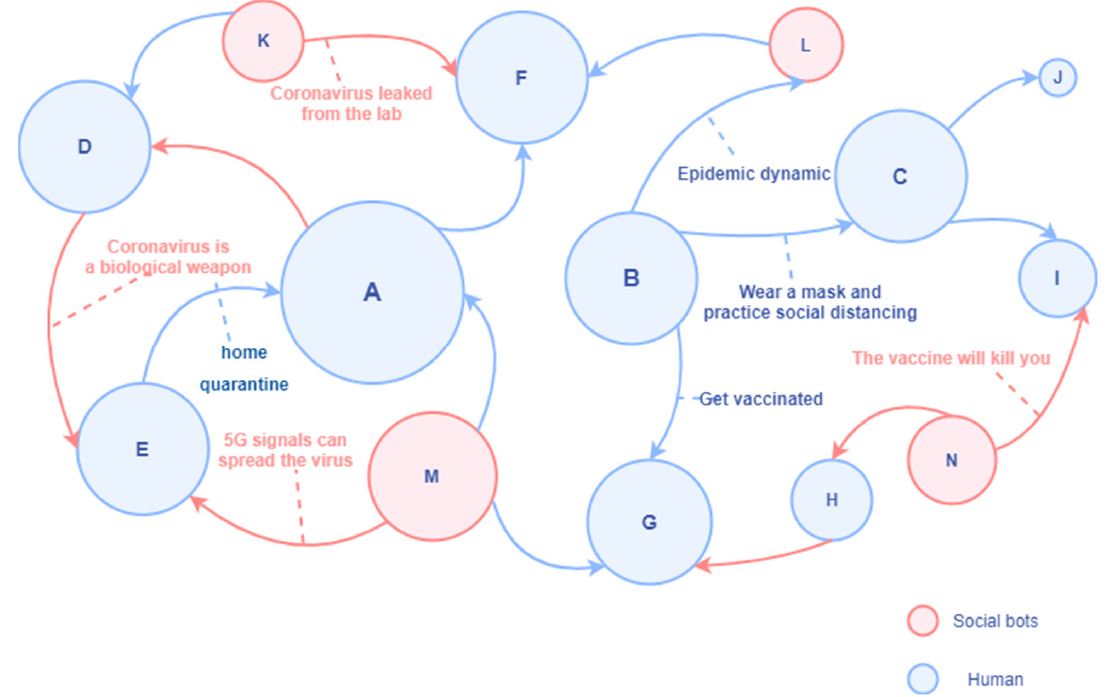
Figure 6. Human-machine communication in the network.